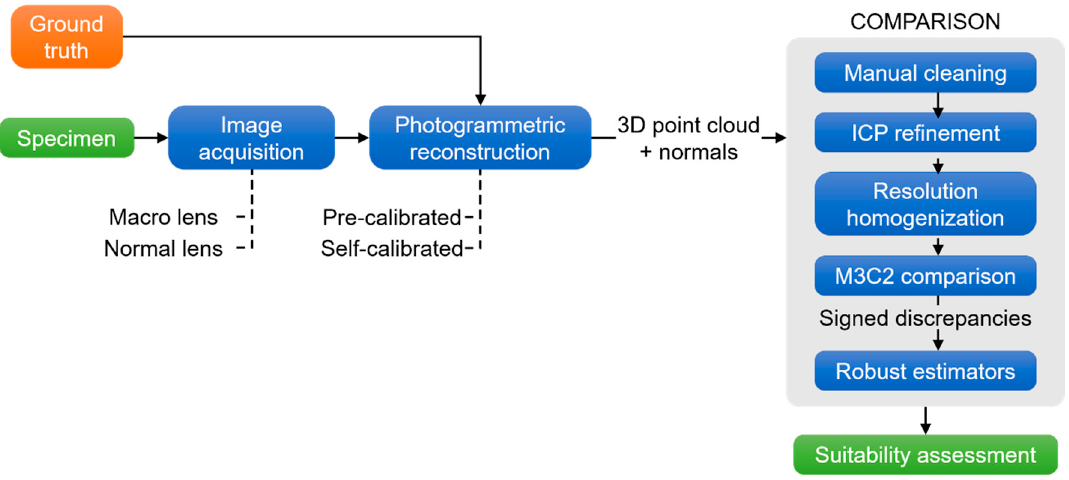
Figure 1. Workflow of the proposed comparison methodology. ICP: Iterative Closest Point; M3C2: Multiscale Model to Model Cloud Comparison; 3D: Three-Dimensional.